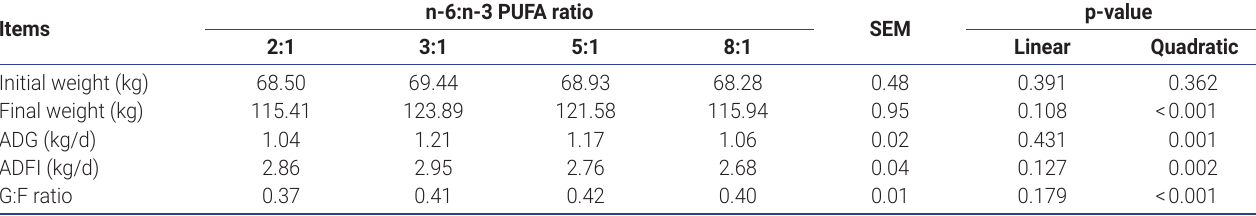
Table 4. Effects of dietary n-6:n-3 PUFA ratios on growth performance of finishing pigs